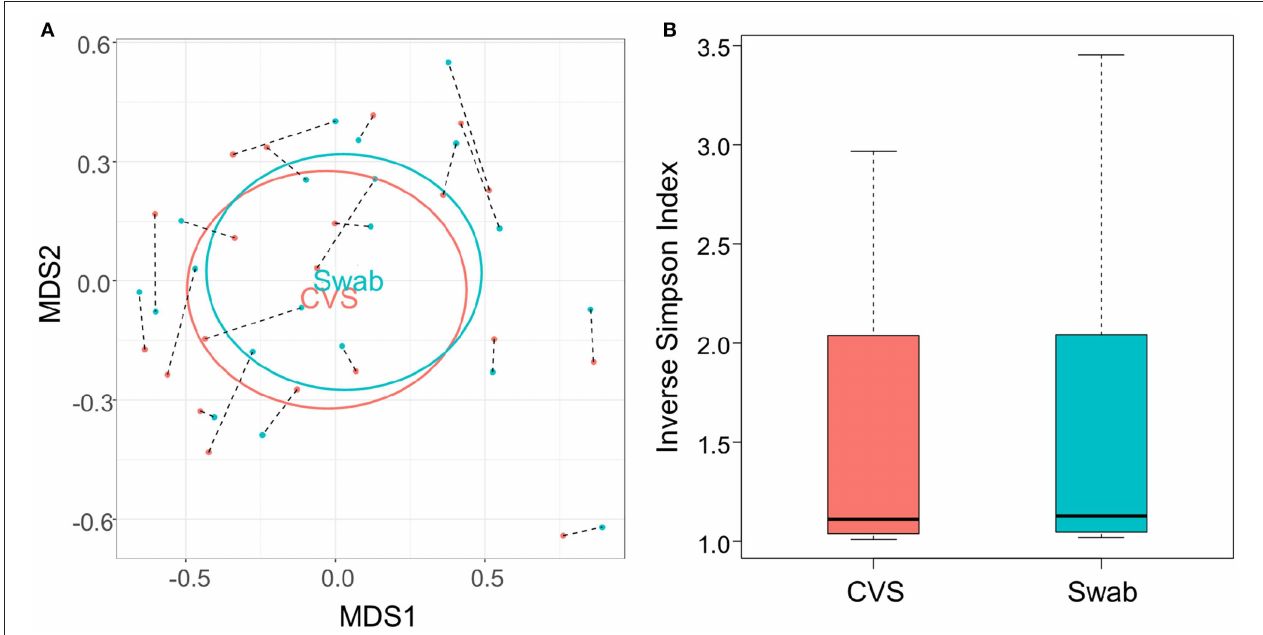
FIGURE 2 | (A) NMDS plot of the Bray-Curtis dissimilarity matrix of CVS (pink) and swab (blue) samples. Black dashed lines connect each CVS sample with the swab obtained from the same donor. “CVS” and “Swab” are positioned on the centroids of the CVS and swab points, respectively, with standard deviations indicated by the ellipses (not significantly different, p = 0.986). (B) Boxplot of Inverse Simpson Indices calculated for CVS and swab samples (not significantly different, p = 0.7138).